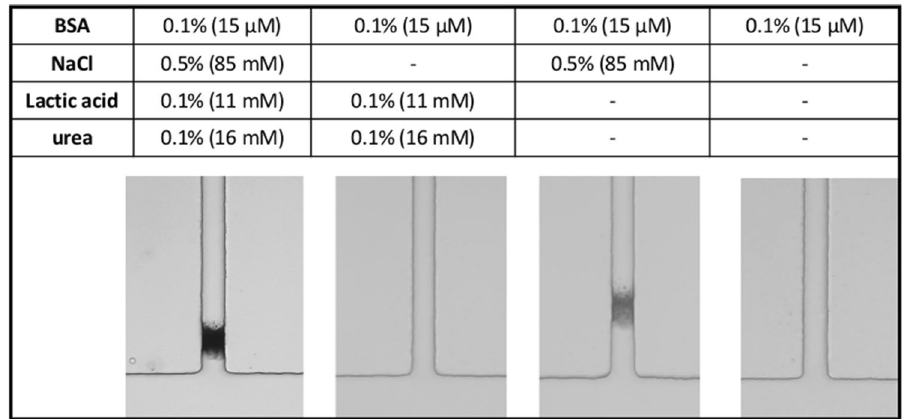
Figure 5. Pictures of plug formation within the sweat channel after 30 min. Same flow conditions as in Fig. 2 caption using artificial sweat of different compositions at pH 6.5. The respective compositions of the artificial sweats are shown in the Table above the